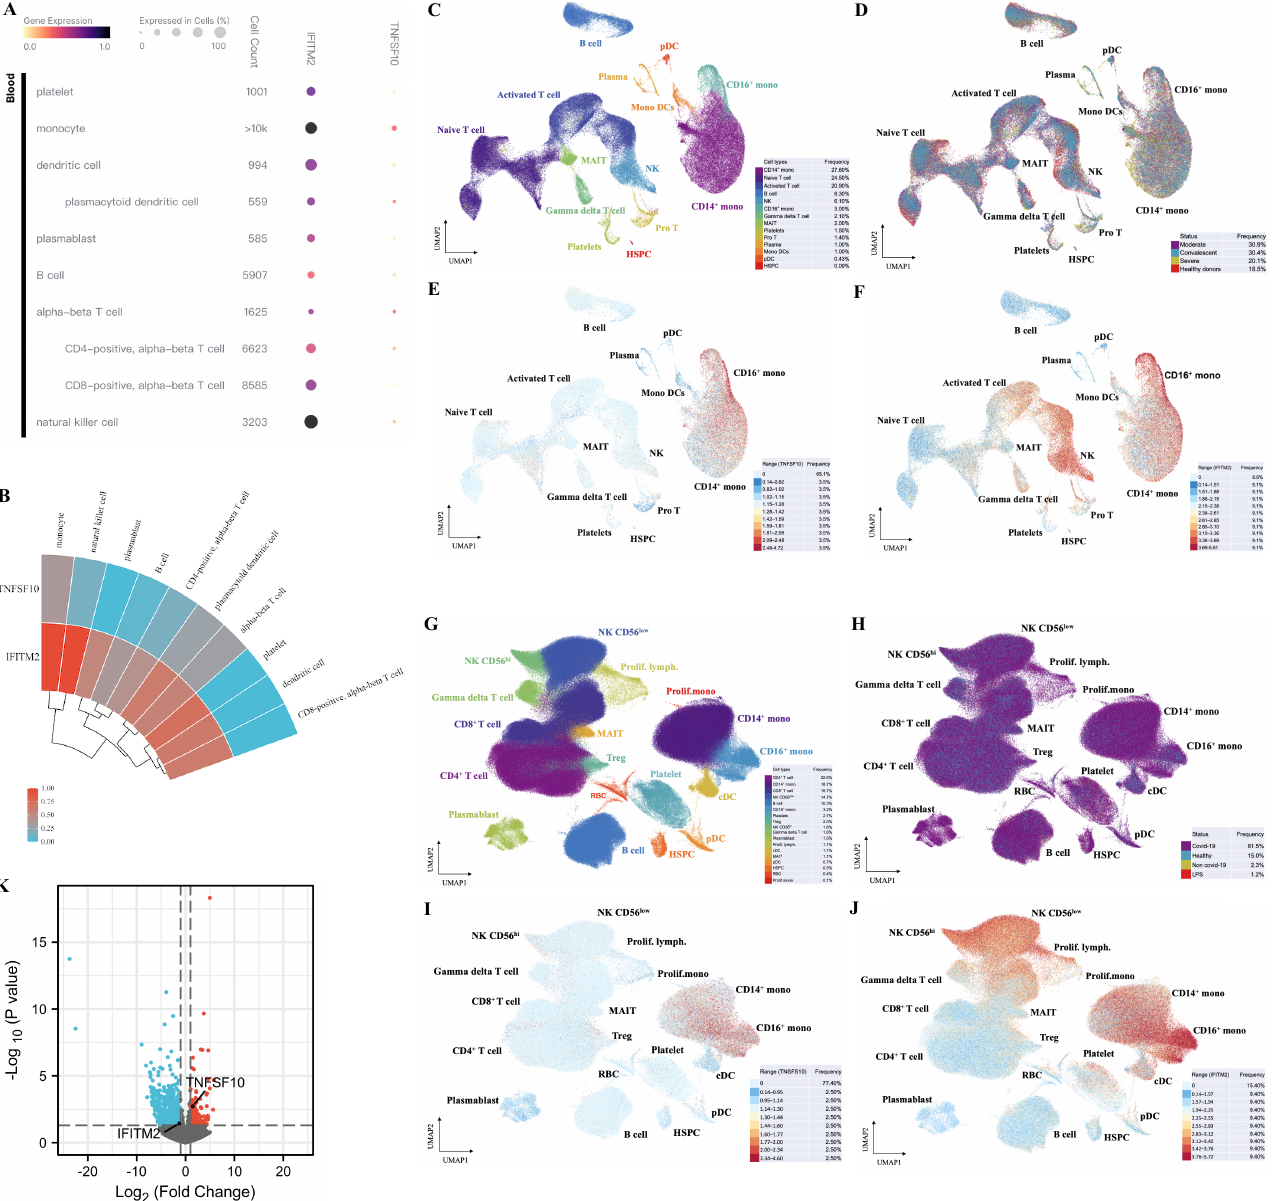
Figure 10. Immunological features of TNFSF10 and IFITM2 in COVID-19 patients with or without cancer by Single-cell RNA-seq analysis. ( A , B ) Based on the PBMC samples from the cellxgene dataset, the expression level of TNFSF10 and IFITM2 in COVID-19 patients without cancer was obtained by Single-cell RNA-seq analysis. More results were based on the single-cell RNA-seq data included in the publication of Zhang et al. (2021) [25] ( C – F ) and Stephenson et al. (2021) [26] ( G – J ). ( C ) The UMAP projection of 122,542 single cells from healthy donors ( n = 5), moderate ( n = 7), severe ( n = 4) and convalescent ( n = 6) COVID-19 patient samples. Each dot represents a single cell. The 14